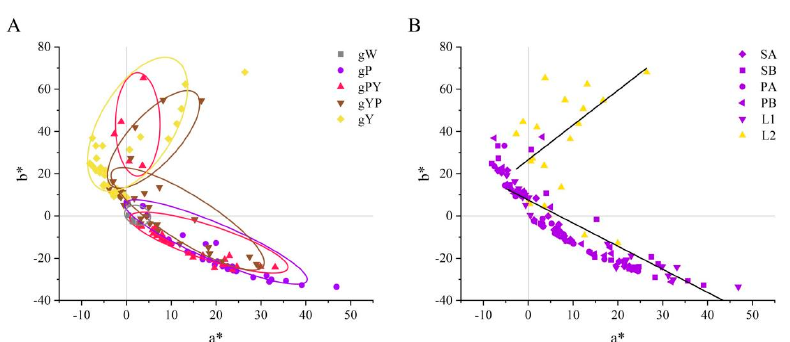
Figure 4. The flower color distribution of Bletilla in two-dimensional coordinate systems of L*, a*, b*. ( A ) Five different color groups a* b* distribution (gW: White B. striata , gP: Pure purple group of B. striata , gPY: Purple perianth yellow lip group of B. striata , gYP: Purple perianth group of B. ochracea , gY: Pure yellow group of B. ochracea ). ( B ) Distribution of a*b* in different flower parts (SA: sepal front, SB: sepal back, PA: petal front, PB: petal back, L1: Lip1, L2: Lip2). An anatomical analysis of White (W), Violet (V), Pink (P), Blue (B), and Yellow (Y) flowers revealed significant differences in cell morphology between different parts of the same flower, and similar cell morphologies in the same parts of different B. striata flowers (Table 2). Lip3 had the highest shape index, followed by Petal and Sepal, which were sim- ilar, then Lip1, and finally Lip2 with the lowest shape index: